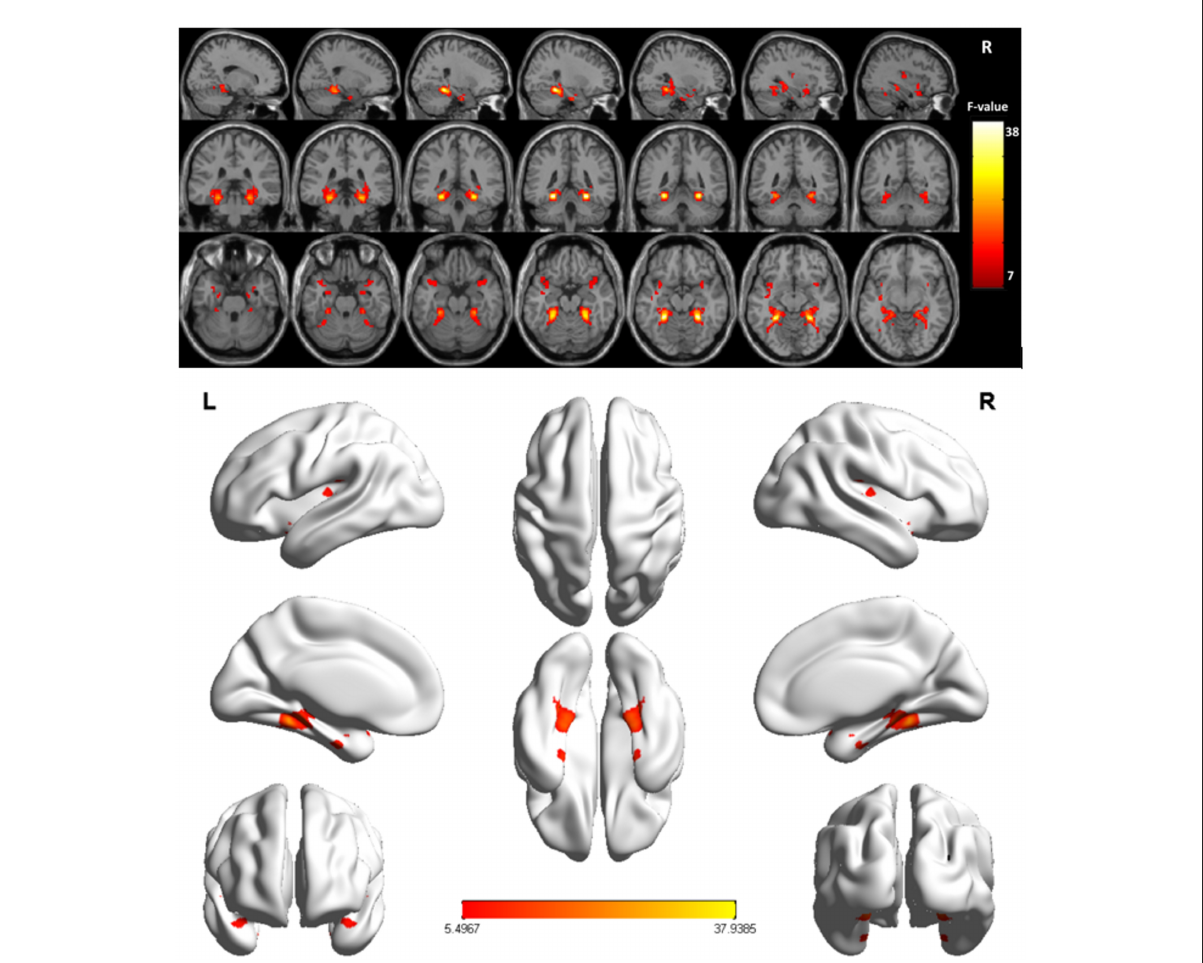
FIGURE1 Significant differences of the VMHC values were fusiform gyrus extending into parahippocampus (fusiform cluster), STG extending into Heschl’s gyrus, insula, and Rolandic operculum (STG cluster) across the three groups (NC, APG and NPG) (Corrected p < 0.005, cluster size = 52). Color bar indicates the F score.